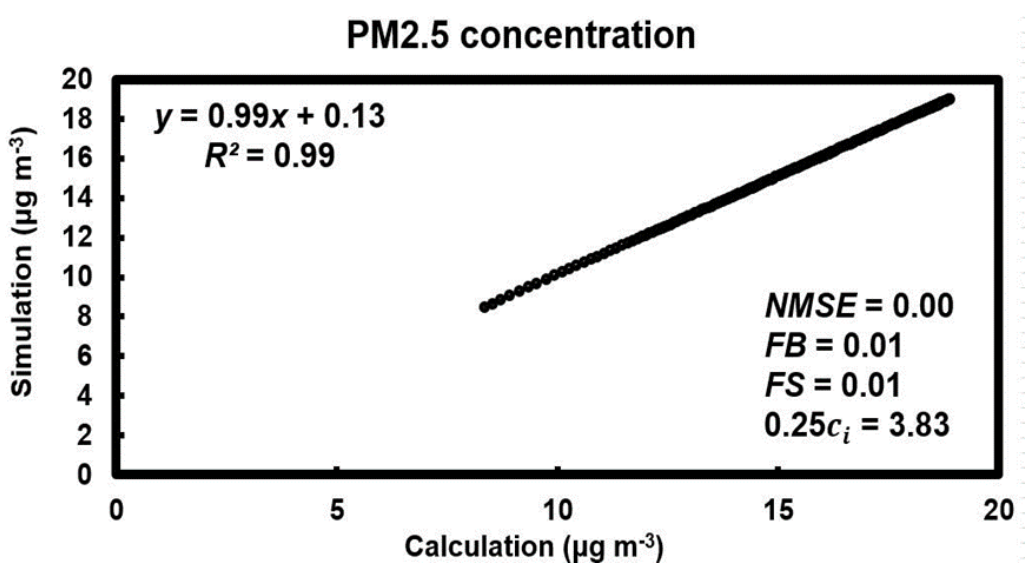
Figure 10. An example of the relationship between PM 2.5 concentrations estimated from Equation 9 and the simulated concentrations at 4 Pa depressurization.